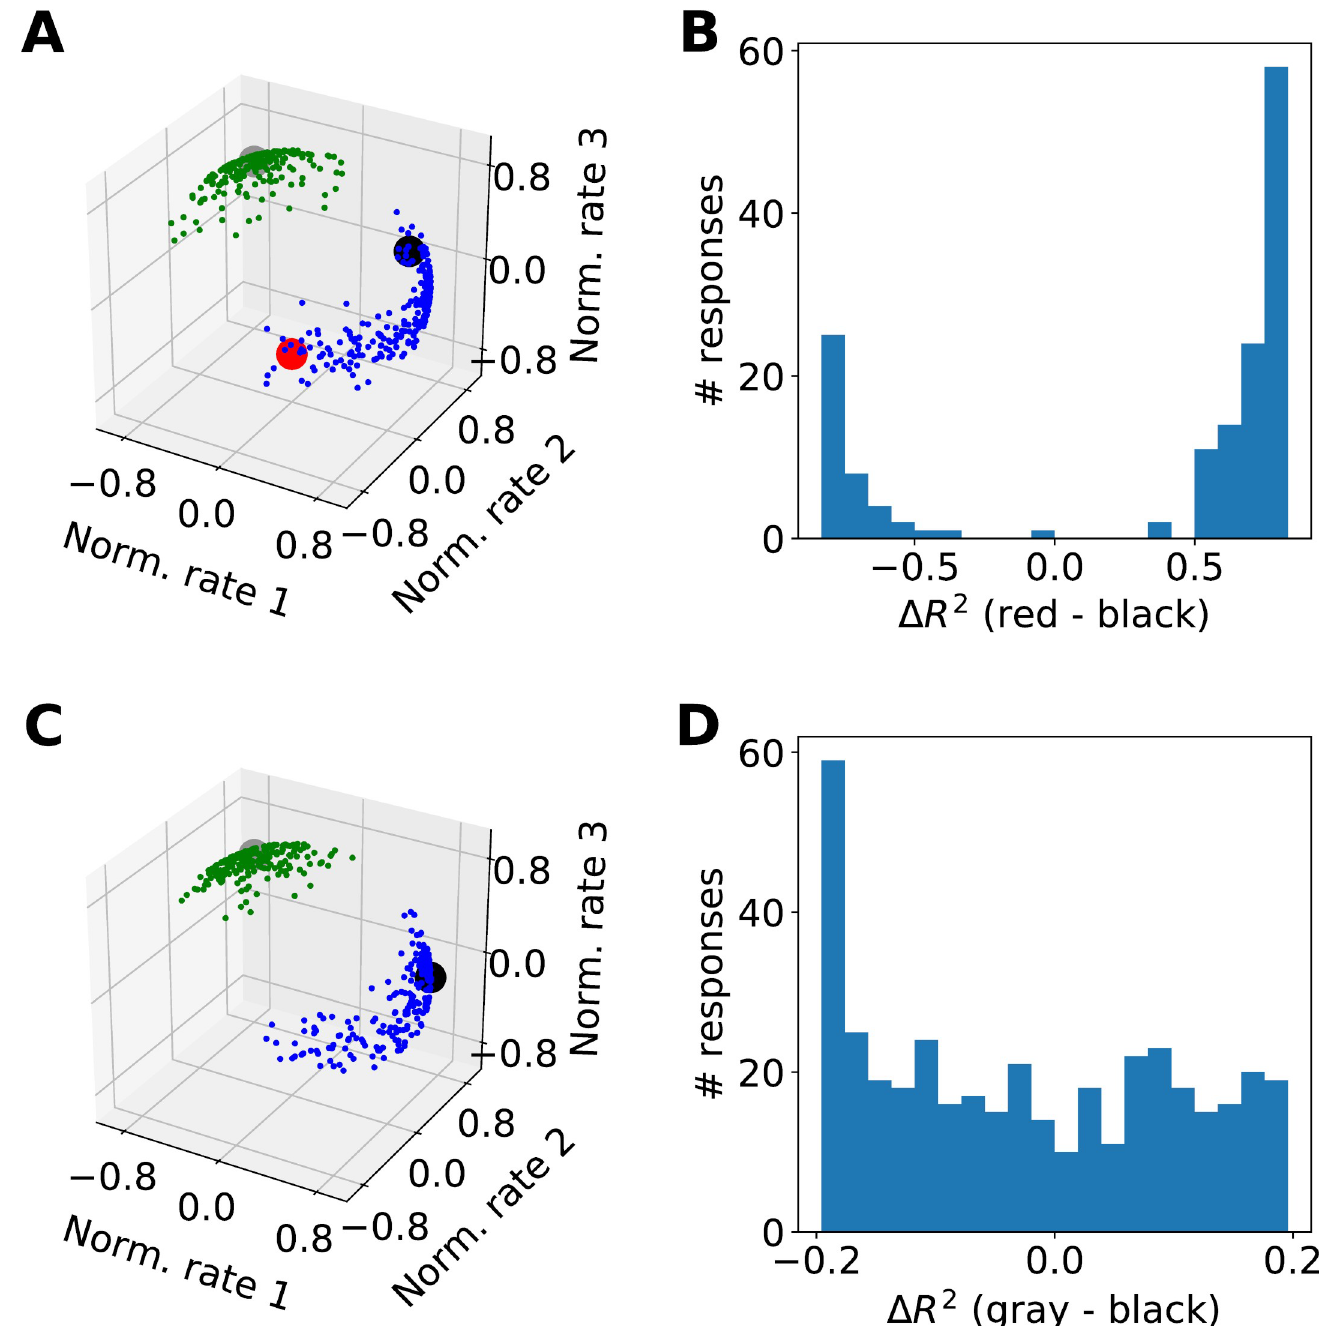
Fig 3. Two examples of how the Δ R 2 metrics can fail. (A,B) A dip in the distribution of Δ R 2 does not necessarily imply categorical encoding. The clustering algorithm yields two clusters. However, the analyst might have erroneously concluded that there are three variables, including two variables located in the tips of the banana cloud (red and black). The dip in the Δ R 2 histogram suggests that these two variables are encoded by categorically distinct populations, but this is in fact not the case. (C,D) Categorical encoding does not always result in a dip in the distribution of Δ R 2 . In this case, we assume that the analyst correctly concluded that there are two variables, but might have defined these variables such that one is on the north pole (gray) and the other is on the east end of the banana cluster (black). Inspection of the Δ R 2 histogram does not reveal any dip. The reason is that data points on the west end of the banana cluster are equally far from the two variables.